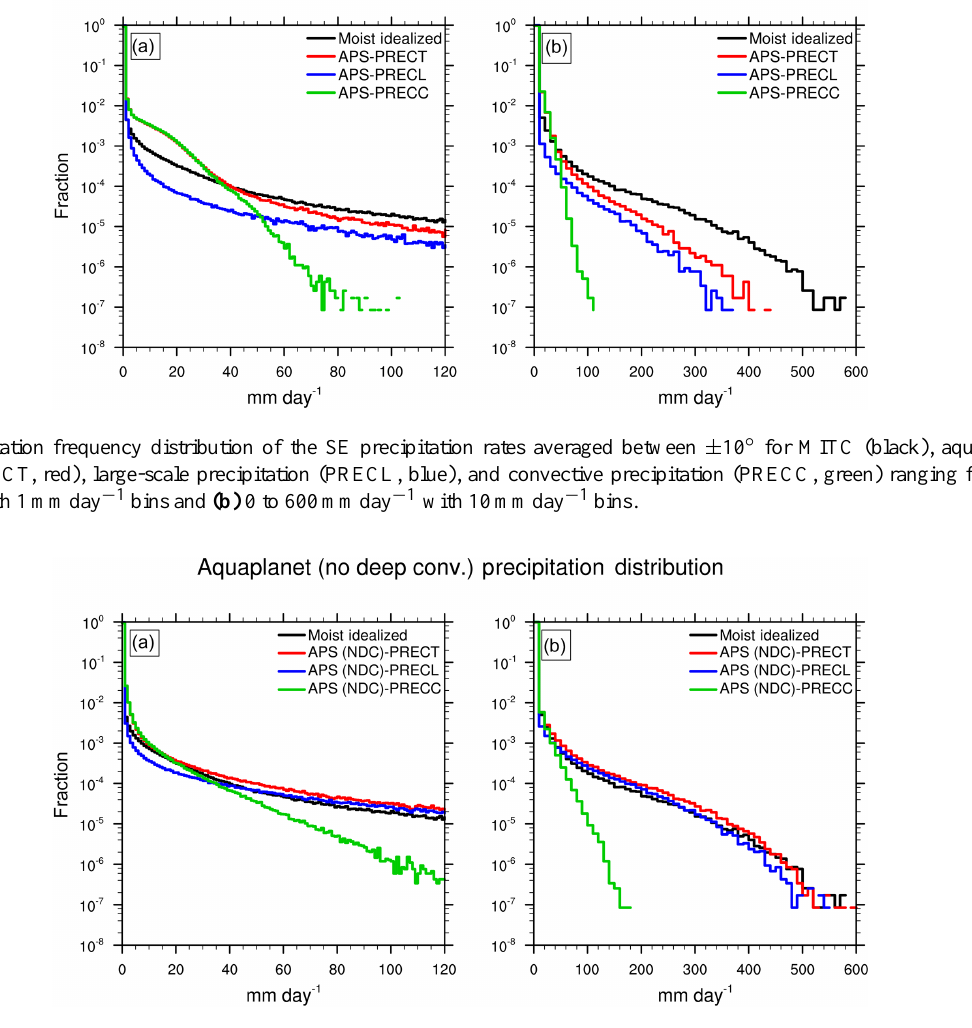
Figure 6. Same as Fig. 5 except comparing to APS